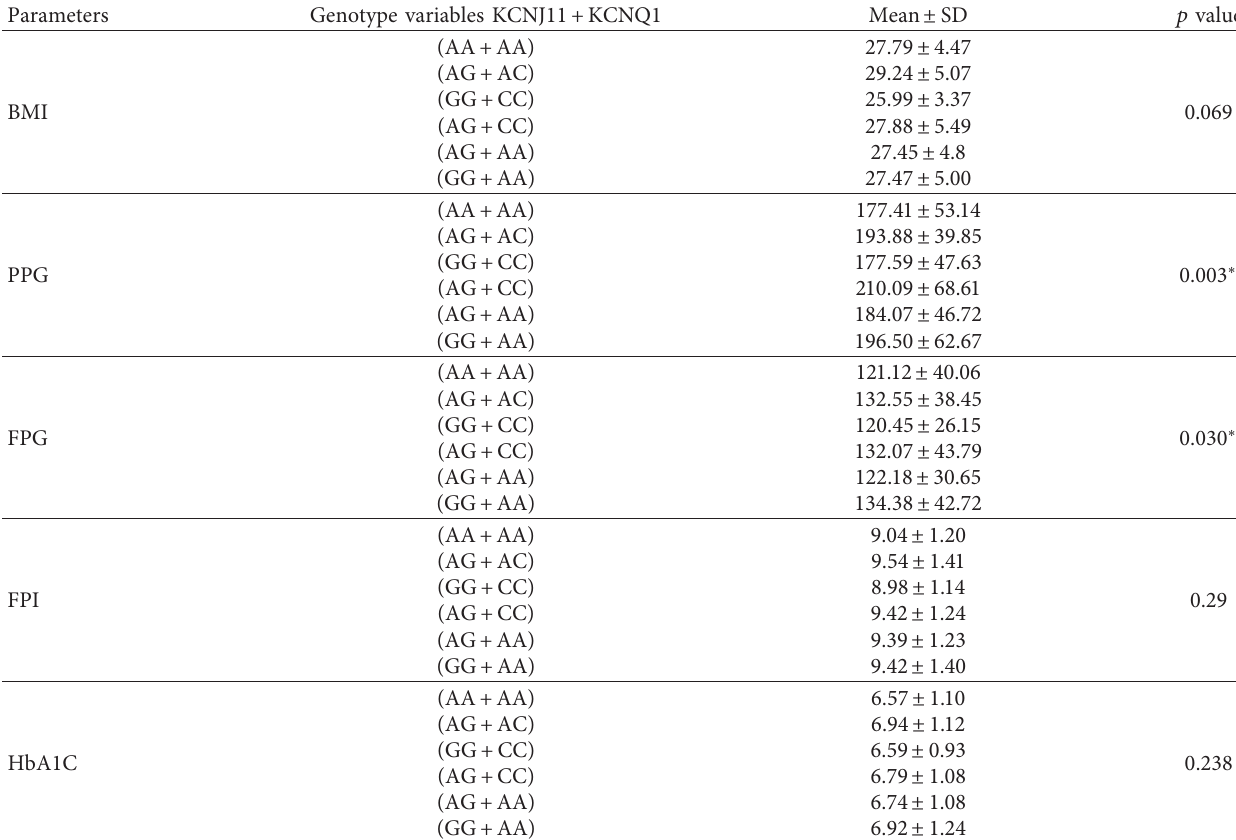
Figure 4: Graphical representation of clinicopathological characteristics of T2DM patients between wild and carrier of a variant allele of the KCNQ1 Table 7: Combined effect of KCNJ11+KCNQ1 genotypes on clinicopathological parameters.